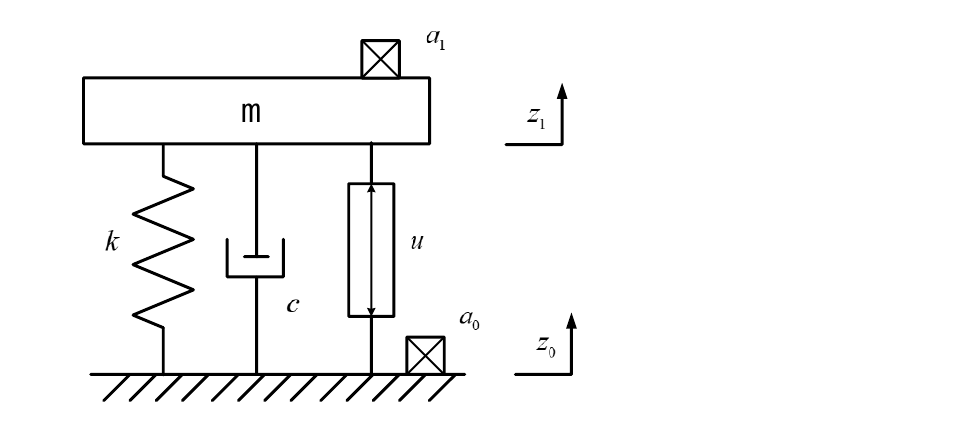
Figure 2. Schematic diagram of the vibration isolation module.